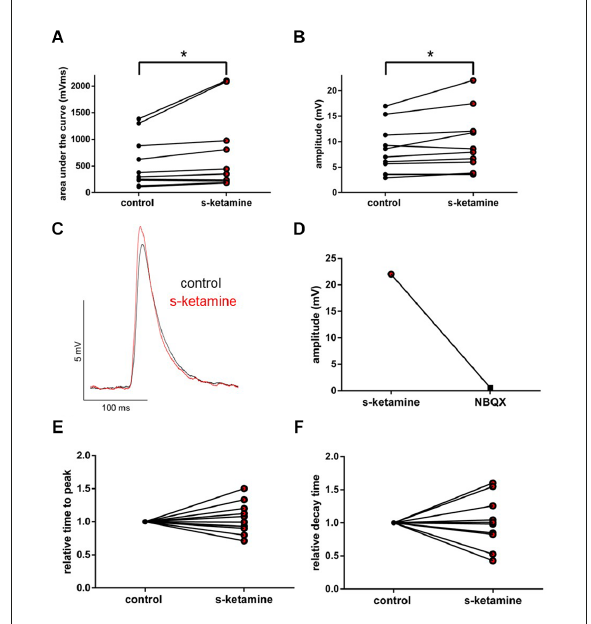
FIGURE9 s-ketamine increased the AUC ( p = 0.010) (A) and the amplitude ( p = 0.014) (B) of thalamocortical AMPA-receptor mediated oEPSPs significantly (*). Cohen’s U3_1 of AUC was 0.8 (0.5 1) and 0.9 (0.7 1) of the amplitude. (C) Representative traces.